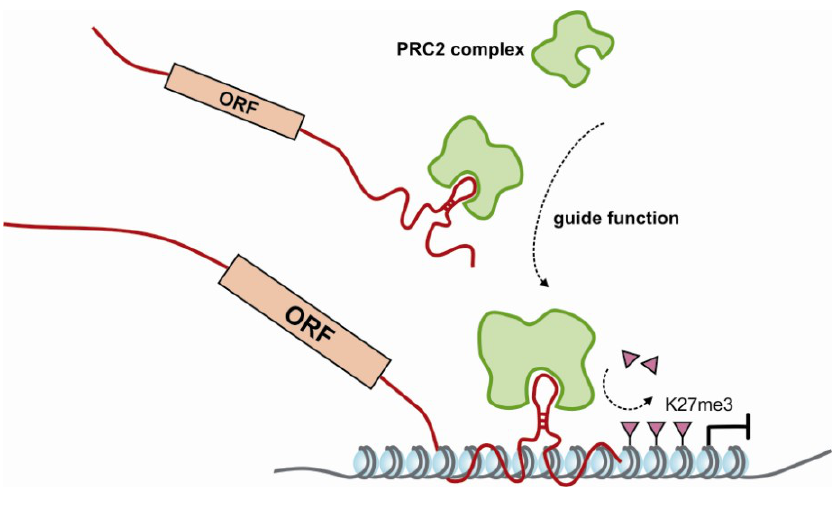
Figure 4. Proposed guide function for mRNA. Many mRNAs have here been shown to interact with PRC2 complex components. Similar to lncRNAs, we propose that mRNAs are involved in guiding the PRC2 complex to its target locations in the genome, where it can repress genomic regions by depositing a trimethyl mark on the lysine 27 residue of histone H3 (K27me3). Which part of the mRNA directly interacts with the PRC2 complex is currently not